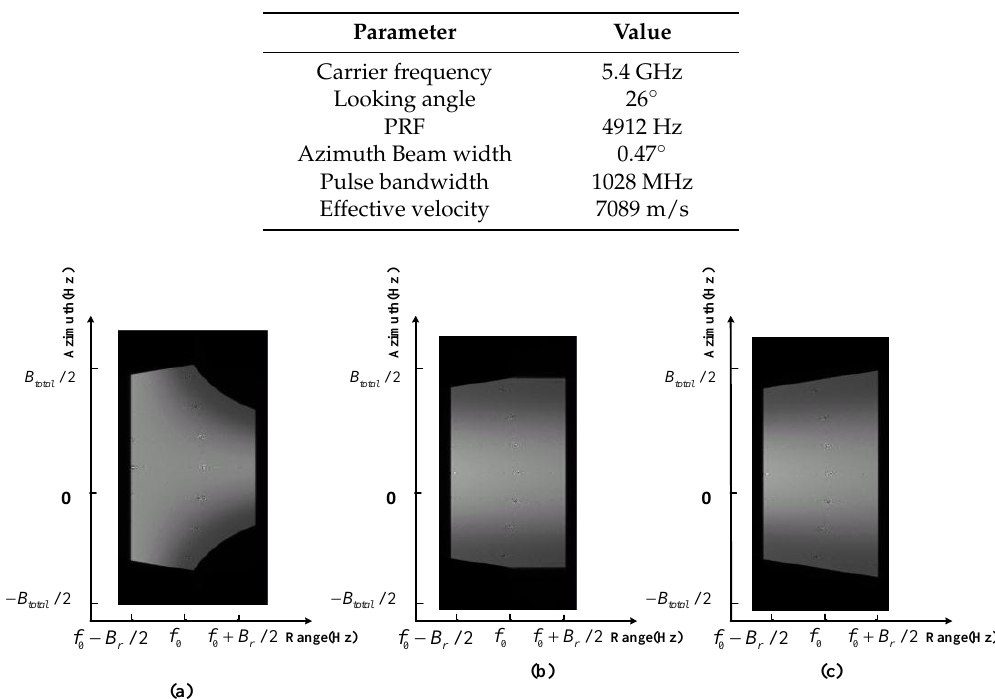
Table 1. System parameters.